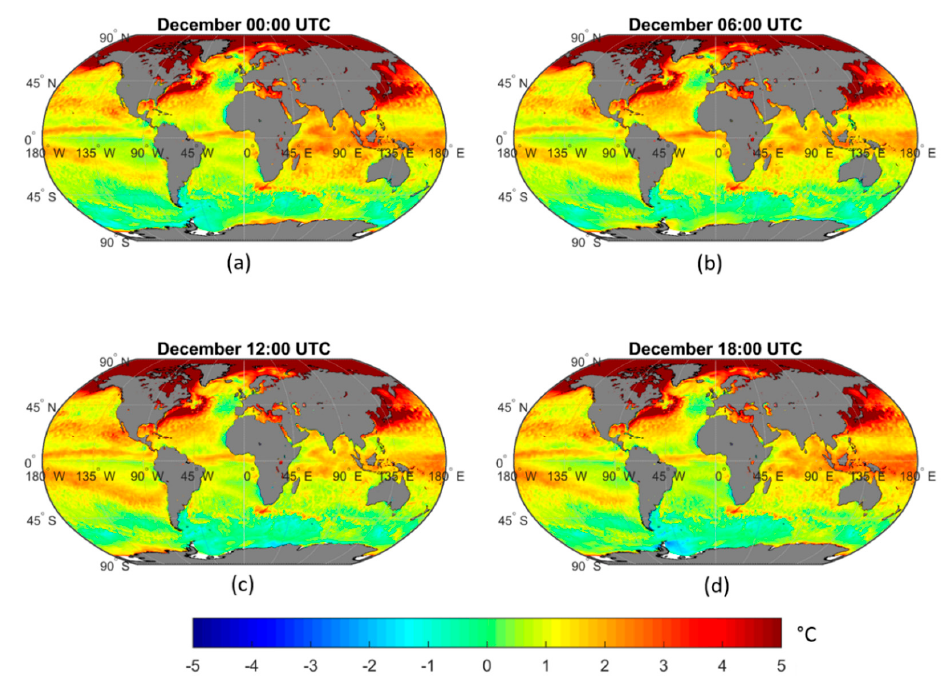
Figure A1. Global maps of monthly average of SST - t2m in the month of December 2018, calculated using ERA5 data [17], for the time steps ( a ) 00:00 UTC; ( b ) 06:00 UTC; ( c ) 12:00 UTC; ( d ) 18:00 UTC.